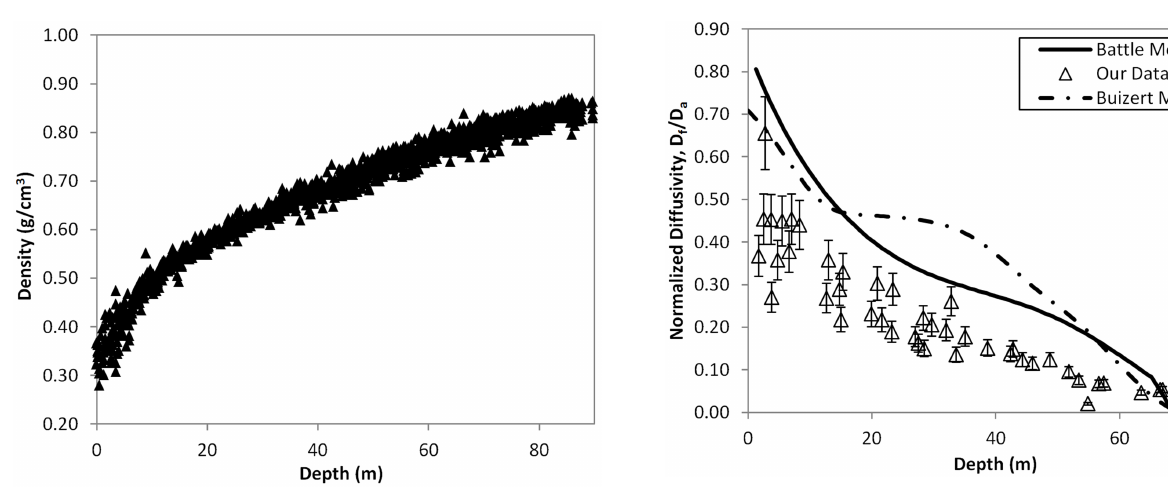
Fig. 2. Density profile for the firn at Summit, Greenland. Fig. 3. Comparison of measured diffusivity to diffusivity modeled from firn air measurements at Summit, Greenland. Error bars show 13% error, estimated from repeat measurements on a single